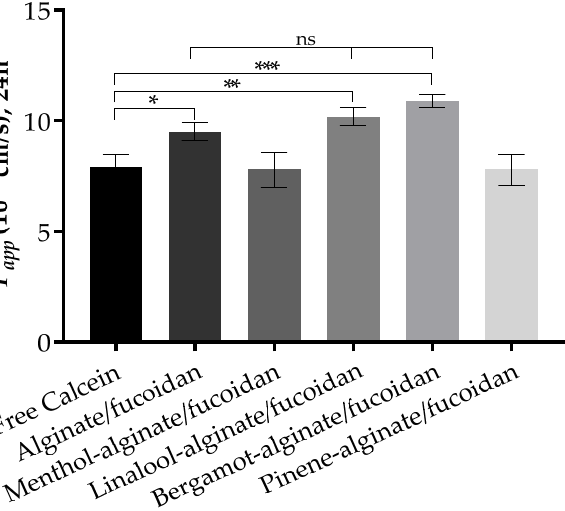
Figure 5. Apparent permeability at 24 h through pig ear skin for all tested sample conditions. Data expressed as mean ± standard deviation of n = 3 replicates. * p < 0.05; ** p < 0.01; *** p < 0.001.